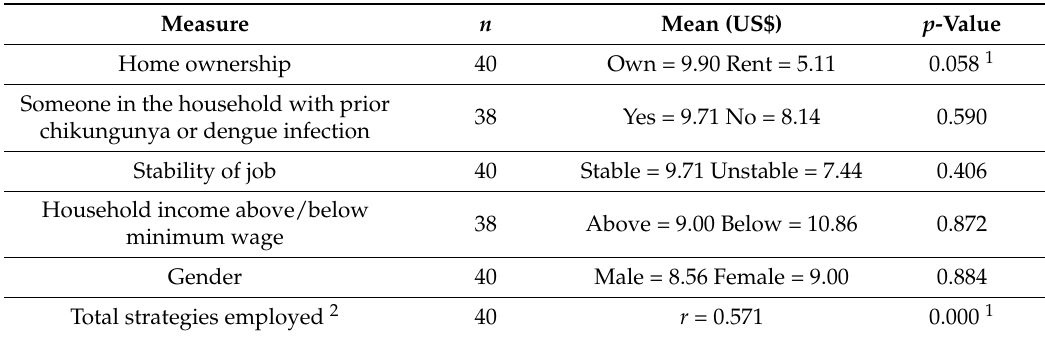
Bi-variate associates of hypothesized predictors of mosquito control and dengue prevention